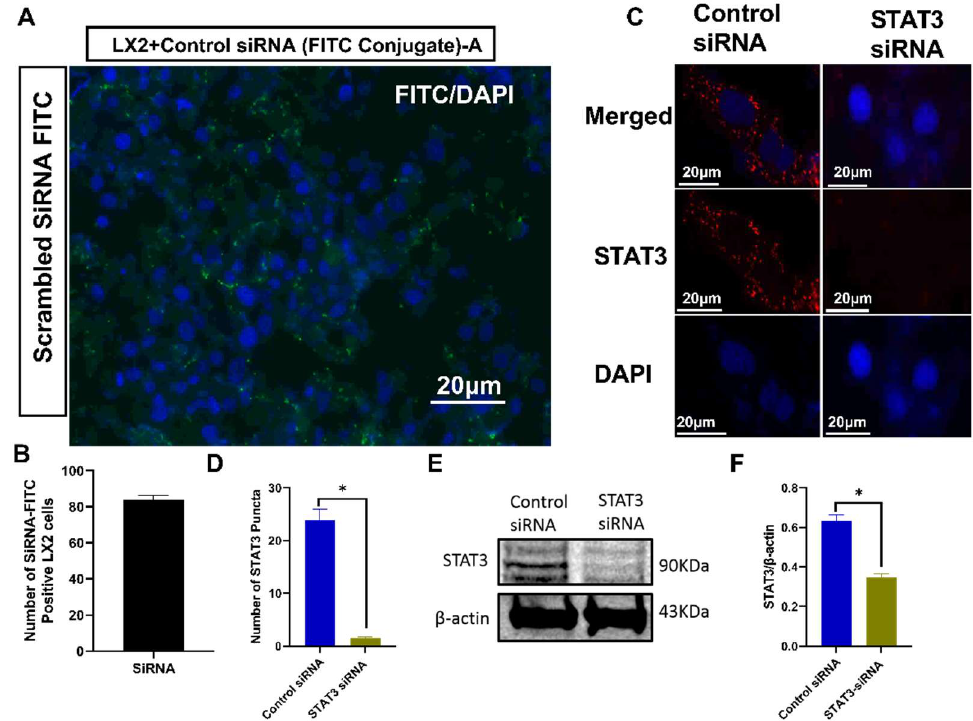
Figure 9. SiRNA transfection of LX2 cells: ( A ) Transfection of LX2 cells with scrambled siRNA-FITC (green). Visualized using a 20 × Keyence microscope. Pictures are representative data from three independent experiments. ( B ) Quantification of transfection efficiency. ( C ) Immunofluorescent staining of STAT3. Staining was visualized using a 20 × lens in Keyence BZ-X810 florescence microscope. Pictures are representative data from three independent experiments. ( D ) STAT3 immunofluorescence intensity was measured using NIH ImageJ. ( E , F ) STAT3 was measured by immunoblot analysis and the quantification of immunoreactive protein bands. Equal amounts of protein (20 µ g) were loaded in each lane. β -actin was used as an internal control. Data are from 3 independent experiments presented as mean ± SEM. Bars with * are significantly different from each other ( p ≤ 0.05).